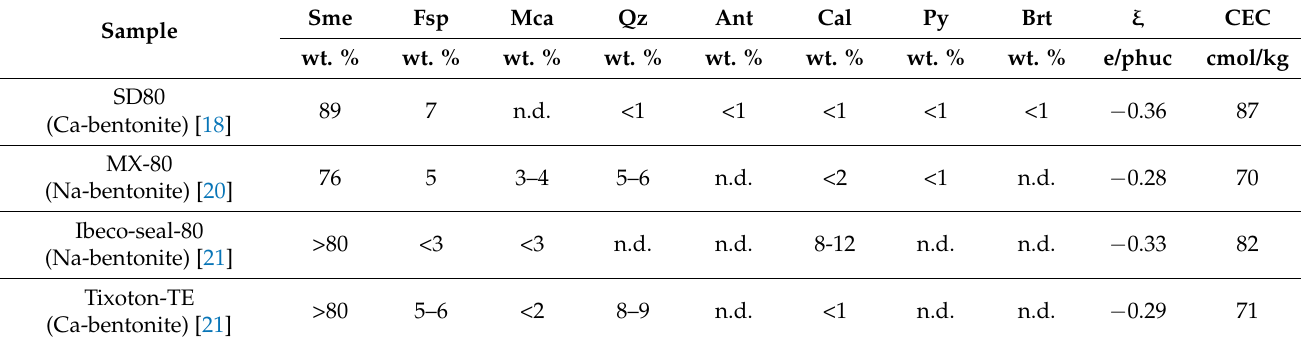
Table 1. Mineral assemblages and properties of SD80 bentonite compared to previously studied bentonite clays investigated by wet-cell X-ray diffractometry. Ant: anatase, Brt: baryte, Cal: calcite, Fsp: feldspar, Sme: smectite, Py: pyrite, Qz: quartz, n.d.: not determined, ξ : total layer charge, CEC: cation exchange capacity. IMA-CNMNC approved mineral symbols, after Warr [19].